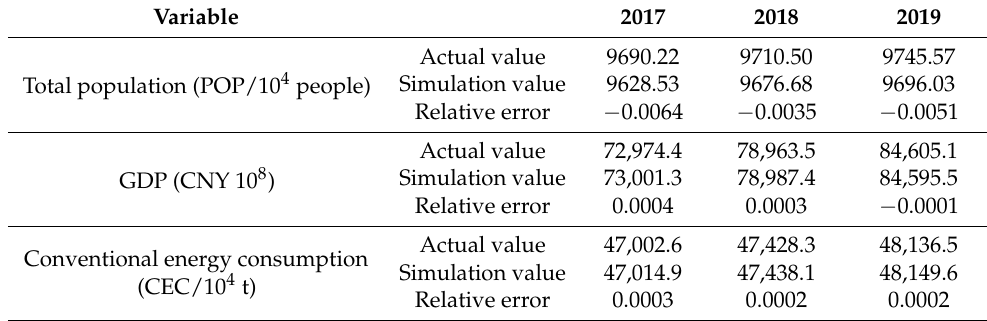
Table 2. Validity check of the SD